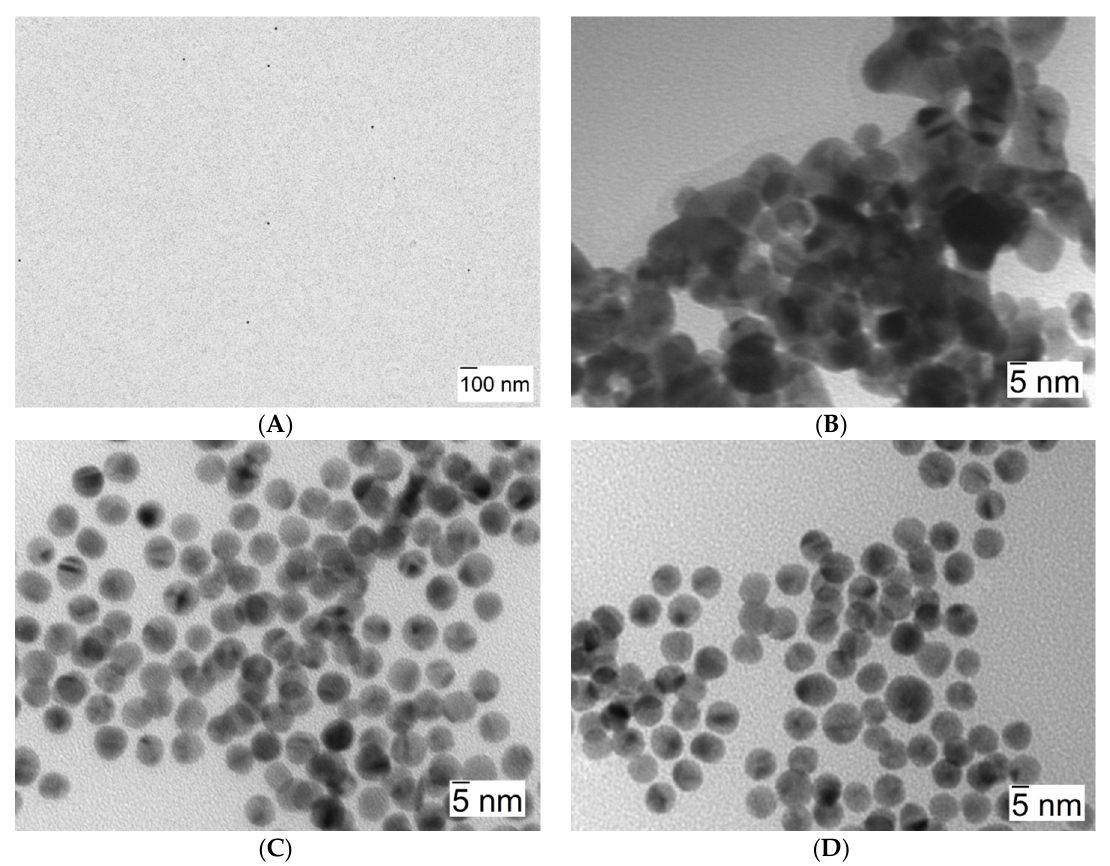
Figure 6. TEM images corresponding to 10 nm AuNPs. ( A ) [AuNPs] = 8.22 × 10 − 10 M, in water (shown at a lesser magnification in order to better convey nanoparticle dispersion). ( B ) [AuNPs] = 8.22 × 10 − 10 M in the presence of [NaCl] = 0.1M. ( C , D ) [AuNPs] = 8.22 × 10 − 10 M in the presence of [Lys] = 4 × 10 − 8 M.